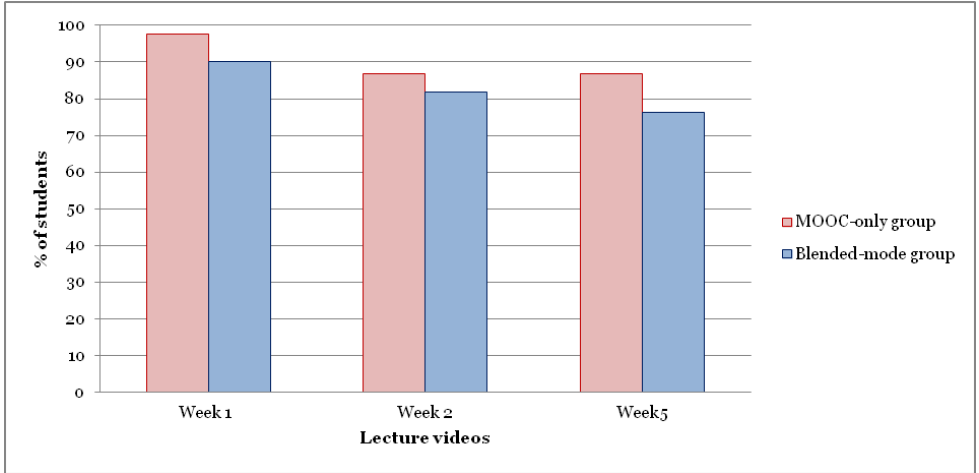
Figure 3. Percentage of students in each group who watched lecture videos.